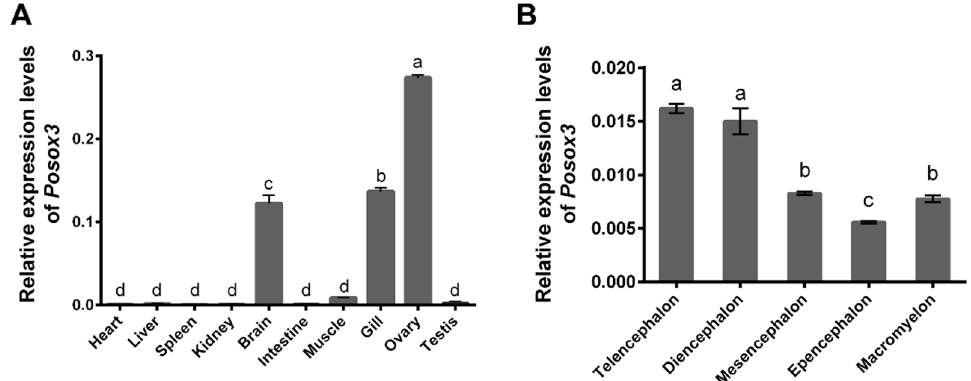
Figure 5. qRT-PCR analysis of Posox 3 in different adult tissues ( A ) and in different parts of adult brain ( B ). Relative mRNA level is shown as mean ± SEM ( n = 3). The relative expression variance is given as ratio (the amounts of Posox 3 mRNA/reference genes). Different letters indicate significant difference ( p < 0.05).